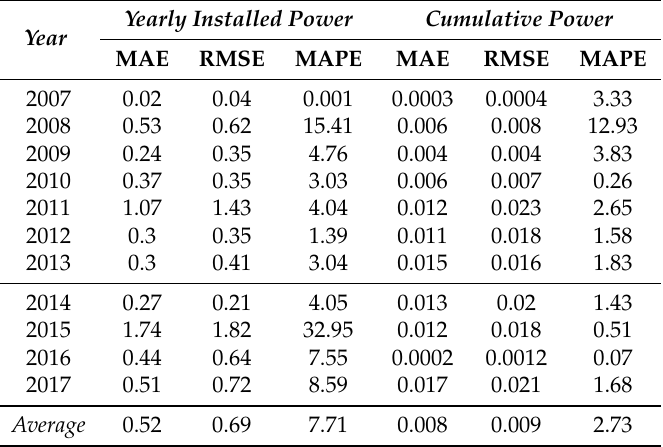
Table 1. Validation and prediction results of installed photovoltaic (PV) power; yearly rate and cumulative installations. Yearly Installed